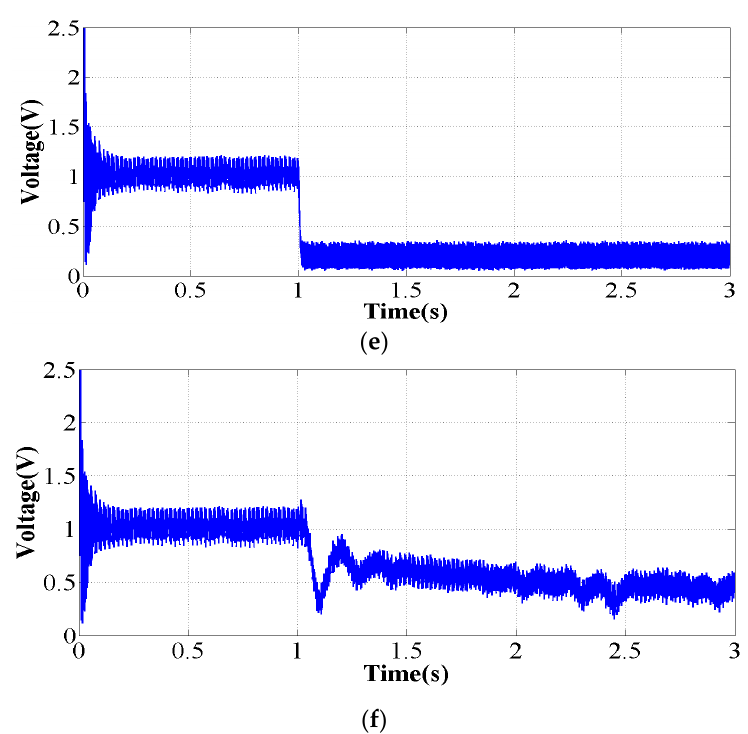
Figure 8. The output voltage analysis in two strategies. ( a ) The fast Fourier transform (FFT) of the line voltage without compensation; ( b ) The FFT of the line voltage with 250 Hz harmonic voltage mitigation with the conventional algorithm; ( c ) The FFT of the line voltage with 250 Hz harmonic voltage mitigation with the proposed algorithm; ( d ) The magnitude of 250 Hz harmonic voltage without compensation; ( e ) The magnitude of 250 Hz harmonic voltage with the conventional algorithm; ( f ) The magnitude of 250 Hz harmonic voltage with the proposed algorithm.